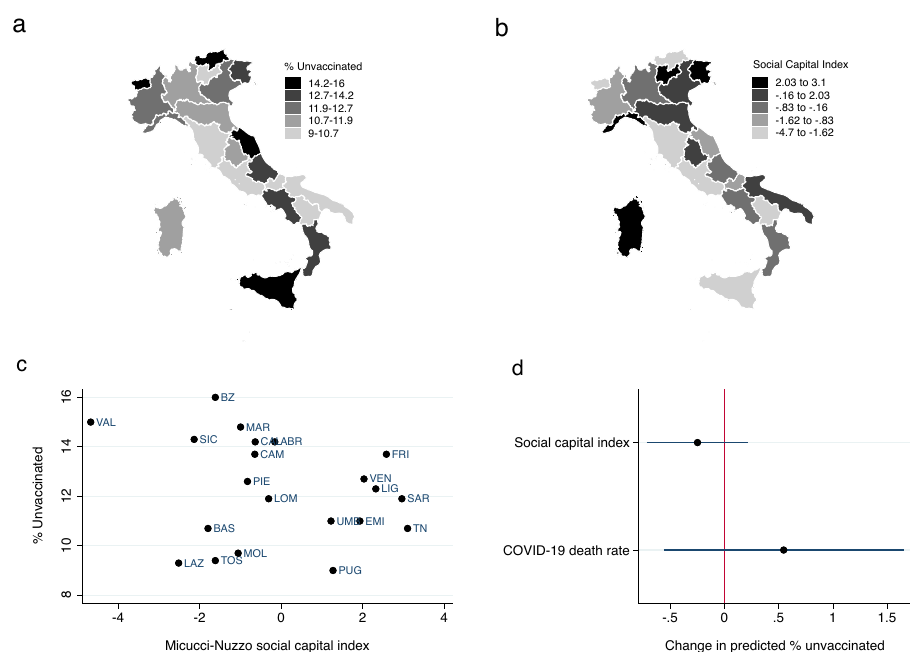
Fig. 1 Regional Social Capital and Rate of Unvaccinated Residents. a plots the percentage of residents who have not received even a single dose of a COVID-19 vaccine by region. b plots an index of macro social capital (capturing civic-mindedness and observance of rules) constructed by Miccucci and Nuzzo. c shows the bivariate relationship between regional social capital and the share of population unvaccinated. d plots coef fi cients and 95% con fi dence intervals from an OLS regression modeling the % unvaccinated as a function of a region ’ s social capital and COVID-19 death